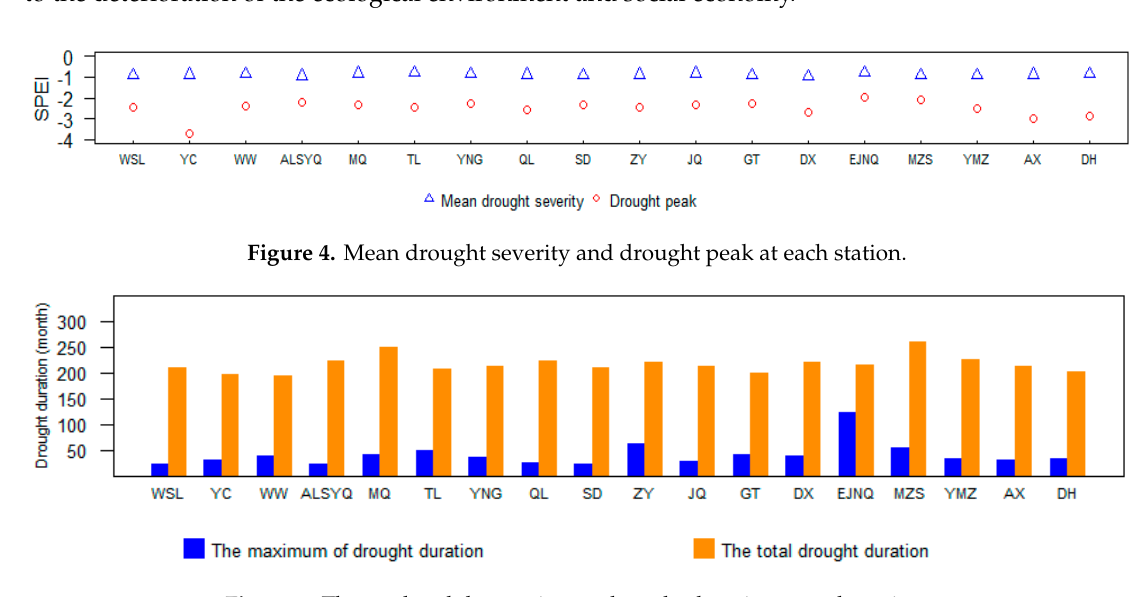
Figure 5. The total and the maximum drought duration at each station.